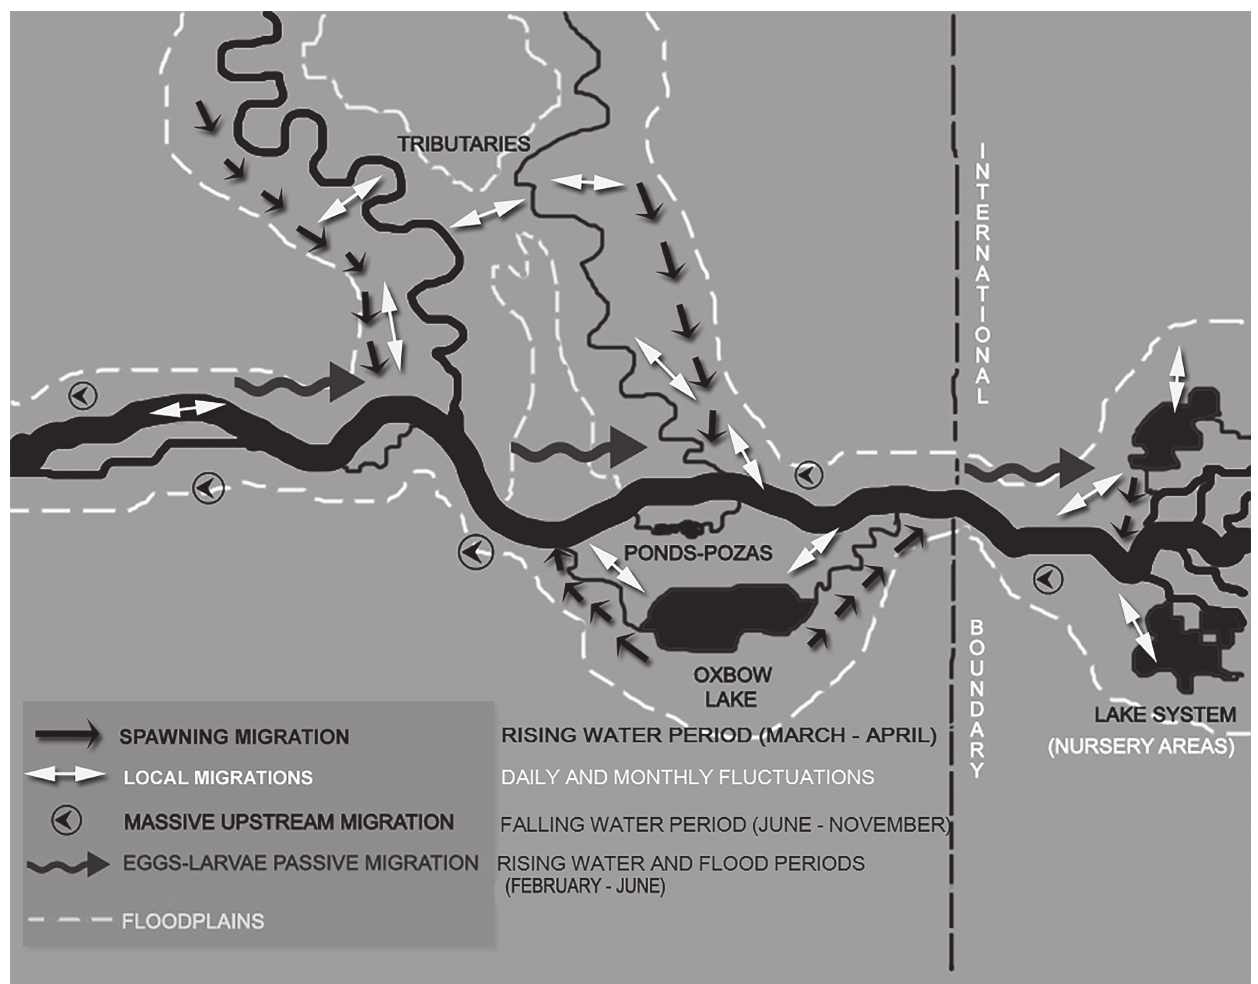
Fig. 6. Proposed graphic model for migration patterns of Prochilodus nigricans in the Napo basin, Ecuador, based on a synthesis of our observations, unstructured interviews with local fishers, and published information on the same species from other